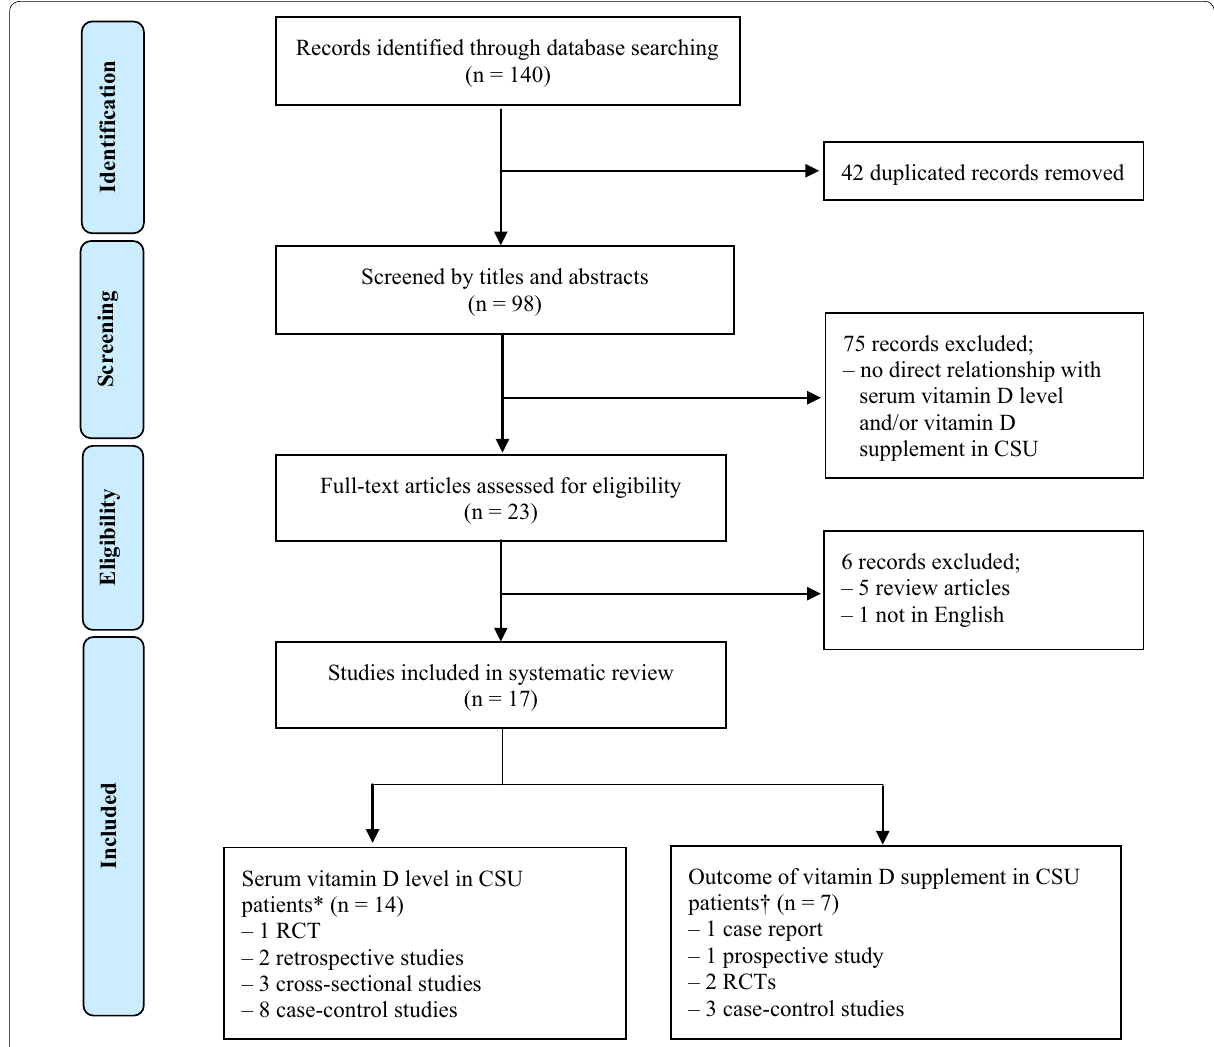
Fig. 1 Flow diagram of literature review in this study. Seventeen studies met the inclusion criteria and were included in our systematic review. *Of the 14 studies, the relation between serum vitamin D level and CSU were assessed [14, 18, 20–25, 28–33]. † In 7 studies, various severity assessment were used to evaluate the effect of vitamin D supplementation in CSU patients [19, 24–27, 31, 32]. CSU chronic spontaneous